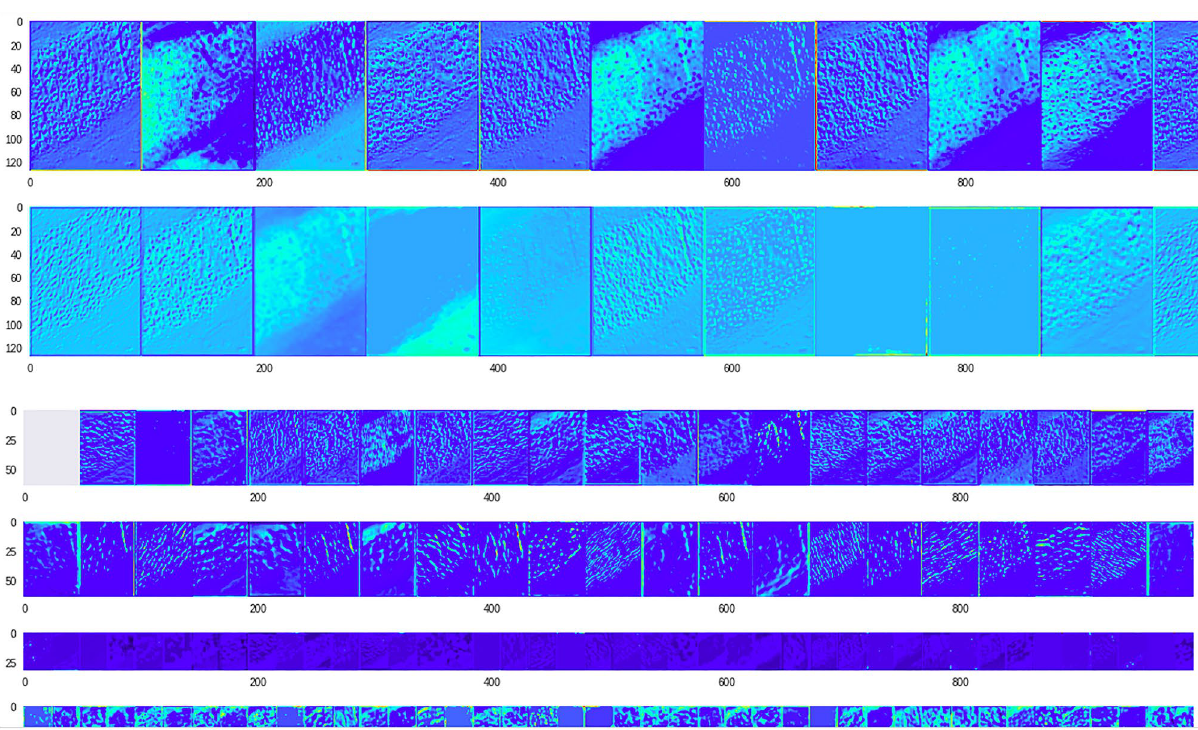
Figure 17. The VML model processing the image from ’trachea’ class (Fig. 16), eventually misclassifying it as ‘cerebellum’. The inner layers (convolution layers only) are represented here. The thick band of cartilaginous tissue is the prominent feature of this image, and has persisted till the last convolution layers. (For visualisation purposes, a psuedocolor scheme has been used to render the deeper layers, and only the first few slices of initial convolution layers are shown) (Figure generated by Matplotlib python library, version 3.3.4, https:// matpl otlib.